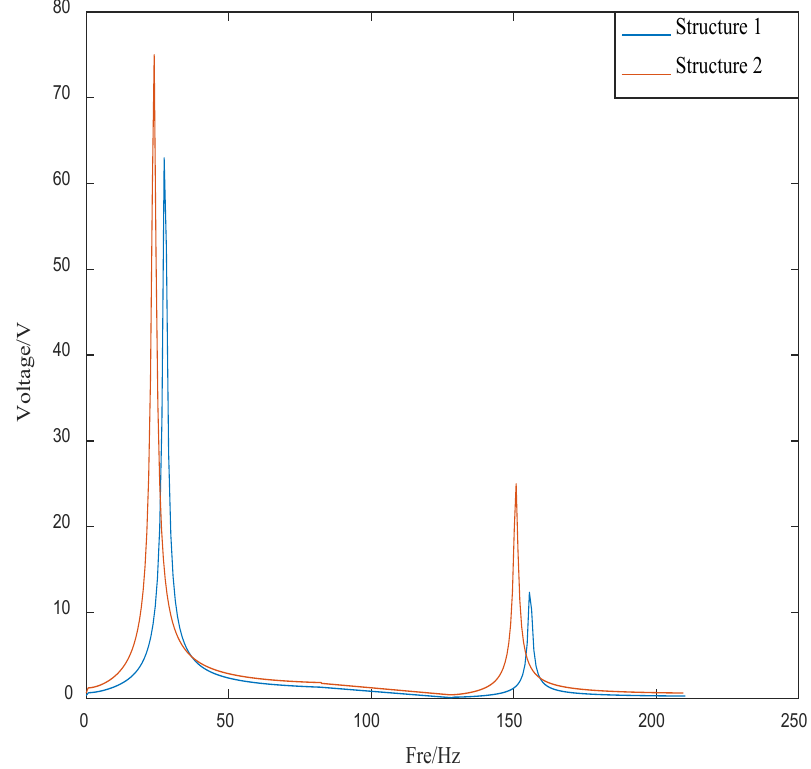
Figure 13. The control voltage of structure 1 and structure 2 after FFT conversion.